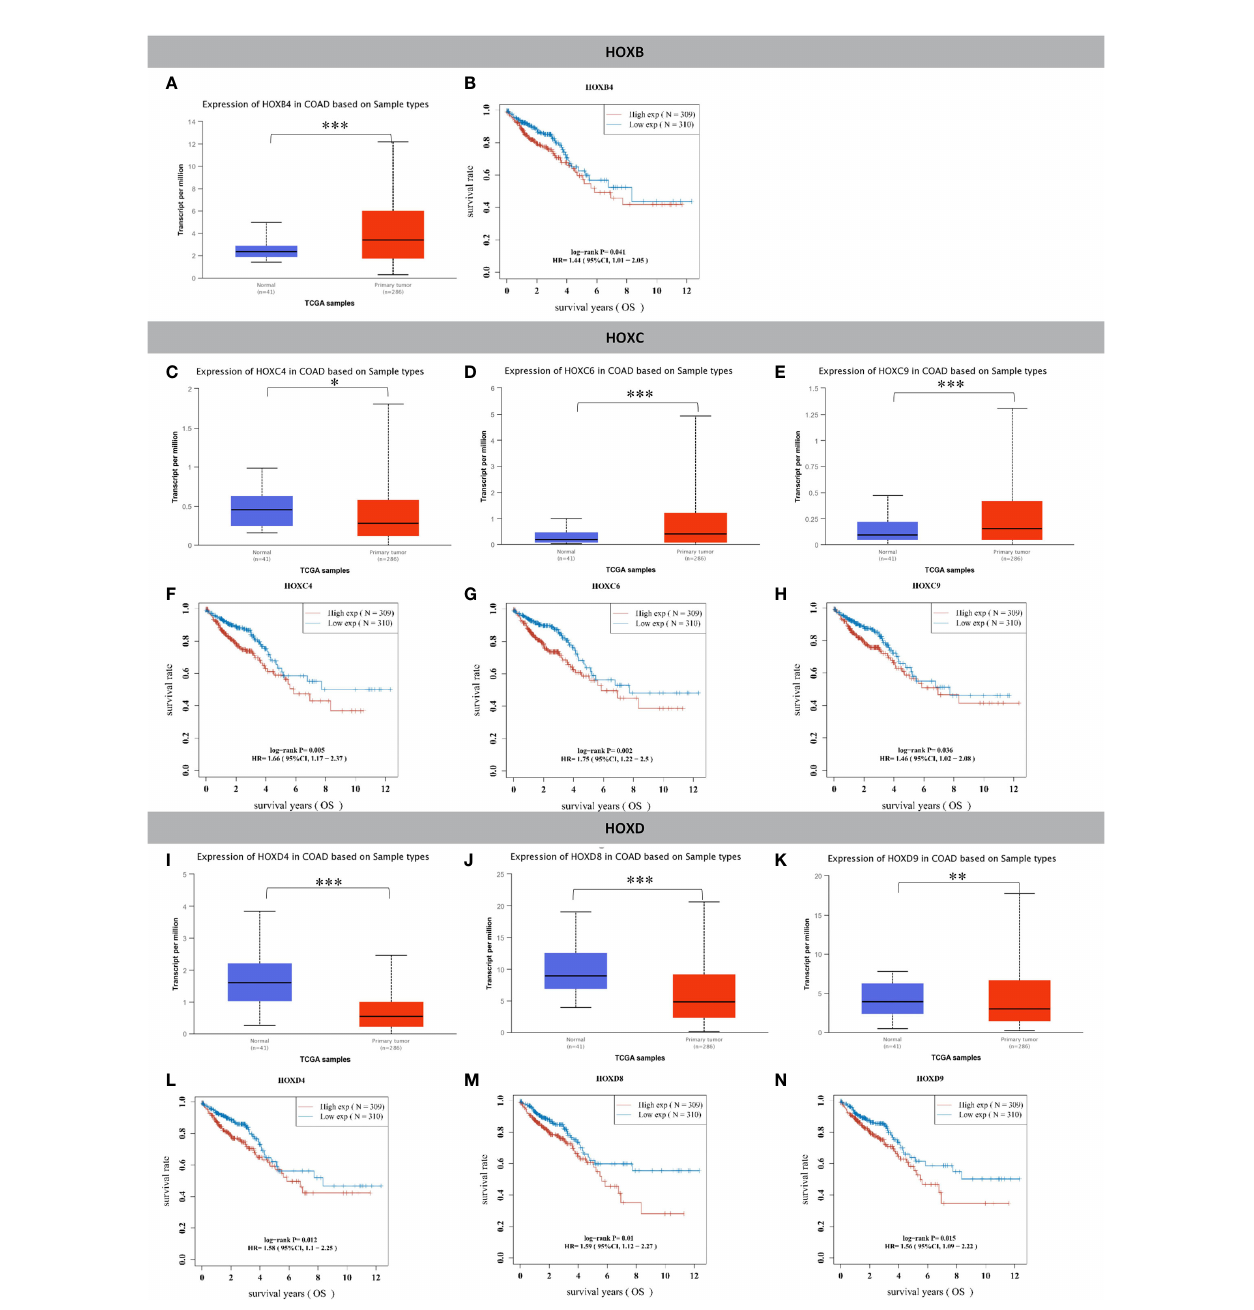
FIGURE 1 | HOX family genes were signi fi cantly differentially expressed in tumor tissues compared to normal colon tissues and had signi fi cant prognostic value. (A) HOXB4 was signi fi cantly upregulated in colon cancer compared to normal tissues. (B) The HOXB4 high expression group had signi fi cantly worse OS than the low expression group in CRC. (C) HOXC4 was signi fi cantly downregulated in colon cancer compared to normal tissues. (D) HOXC6 was signi fi cantly upregulated in colon cancer compared to normal tissues. (E) HOXC9 was signi fi cantly upregulated in colon cancer compared to normal tissues. (F) The HOXC4 high expression group had signi fi cantly worse OS than the low expression group in CRC. (G) The HOXC6 high expression group had signi fi cantly worse OS than the low expression group in CRC. (H) The HOXC9 high expression group had signi fi cantly worse OS than the low expression group in CRC. (I) HOXD4 was signi fi cantly downregulated in colon cancer compared to normal tissues. (J) HOXD8 was signi fi cantly downregulated in colon cancer compared to normal tissues. (K) HOXD9 was signi fi cantly downregulated in colon cancer compared to normal tissues. (L) The HOXD4 high expression group had signi fi cantly worse OS than the low expression group in CRC. (M) The HOXD8 high expression group had signi fi cantly worse OS than the low expression group in CRC. (N) The HOXD9 high expression group had signi fi cantly worse OS than the low expression group in CRC. * P < 0.05, ** P < 0.01, *** P <